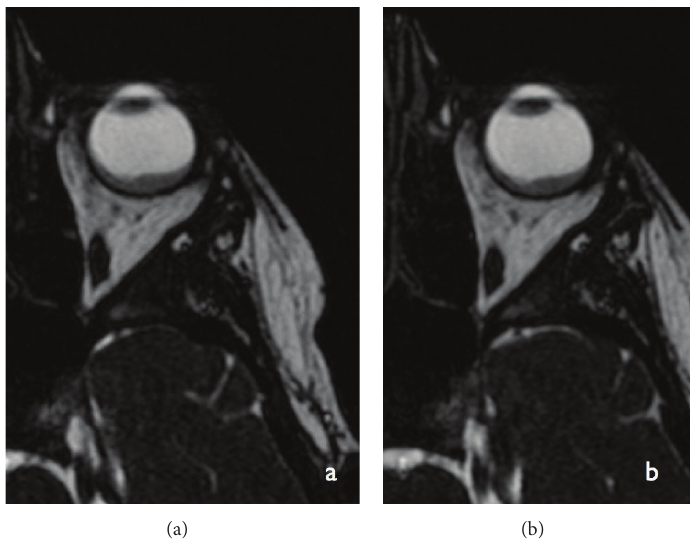
Figure 6: Axial CISS (constructive interference in steady state) MRI images showing that theretinal choroidal lesion shows similar signal characteristics as on T2-weighted images. No calcific signal foci are seen within the lesion. The CISS images provide high spatial resolution and help in radiologically defining the extent of the